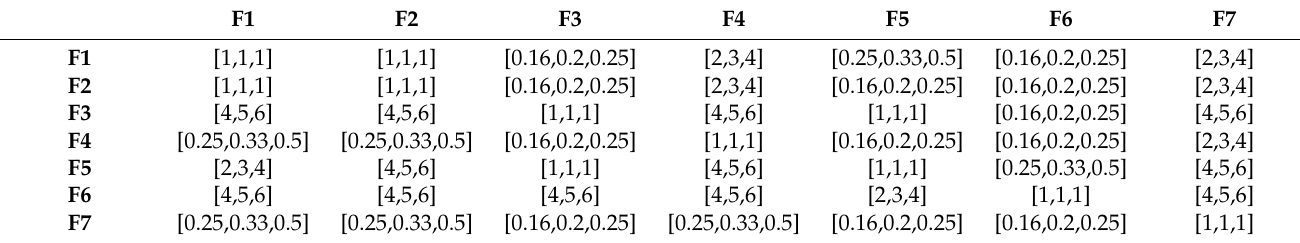
Table A5. The aggregated matrix of fuzzy comparisons (cid:101) A